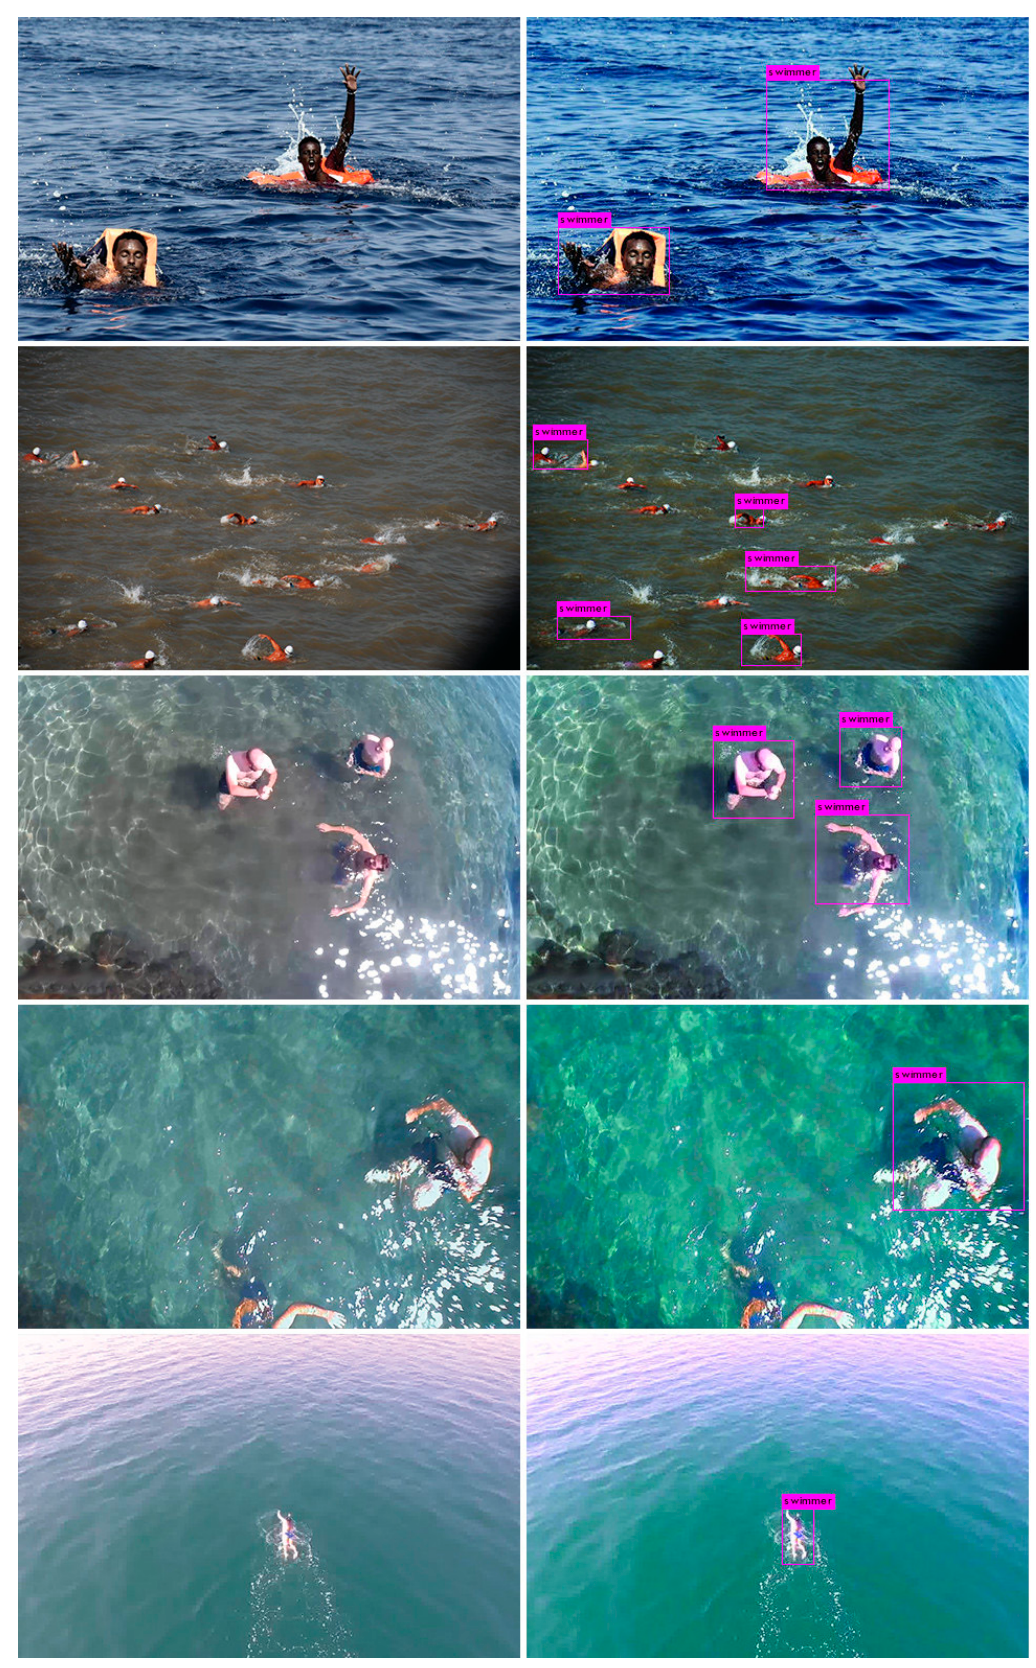
Figure 5. Humans in open waters (left column) before and (right column) after detection procedure.